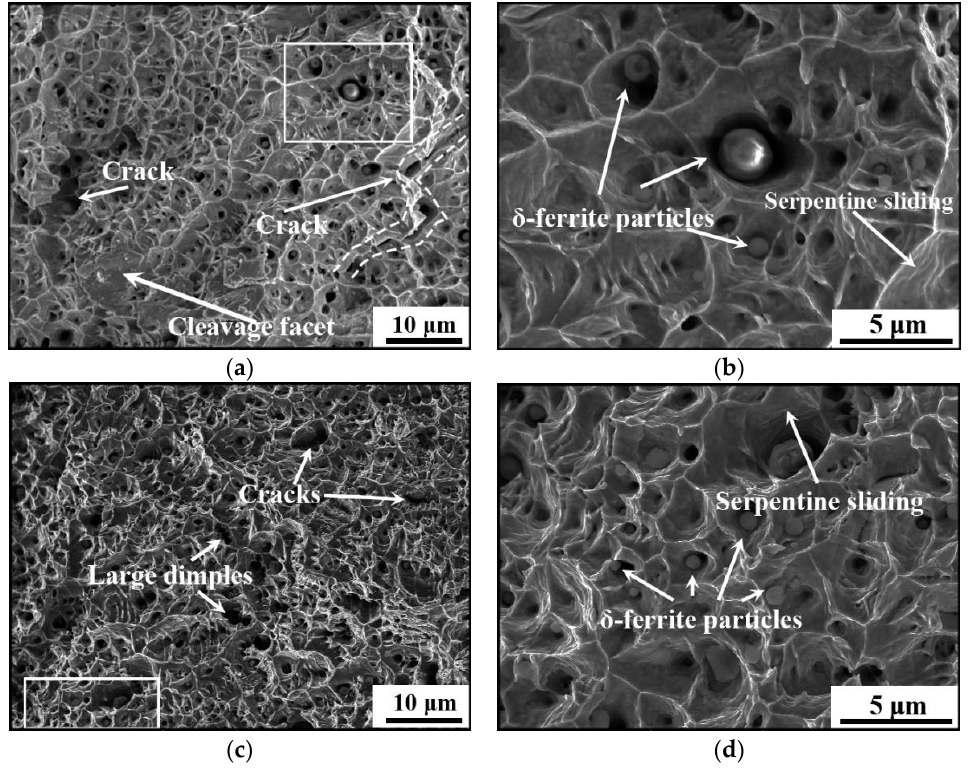
Figure 10. Fracture surfaces of the vertical tensile samples under: ( a , b ) low LEI; and ( c , d ) high LEI.